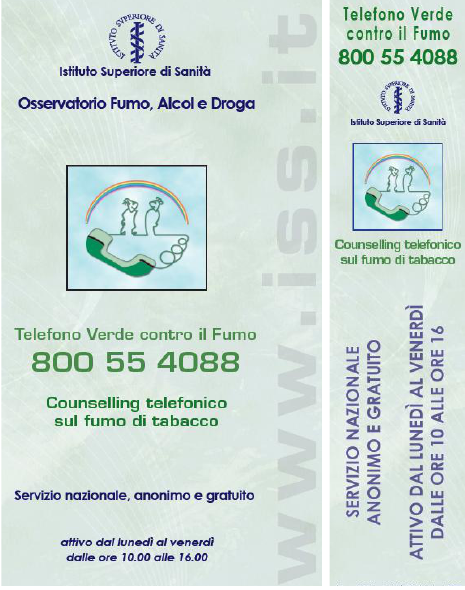
Figure 1. Leaflets and bookmarks of the Italian Antismoking